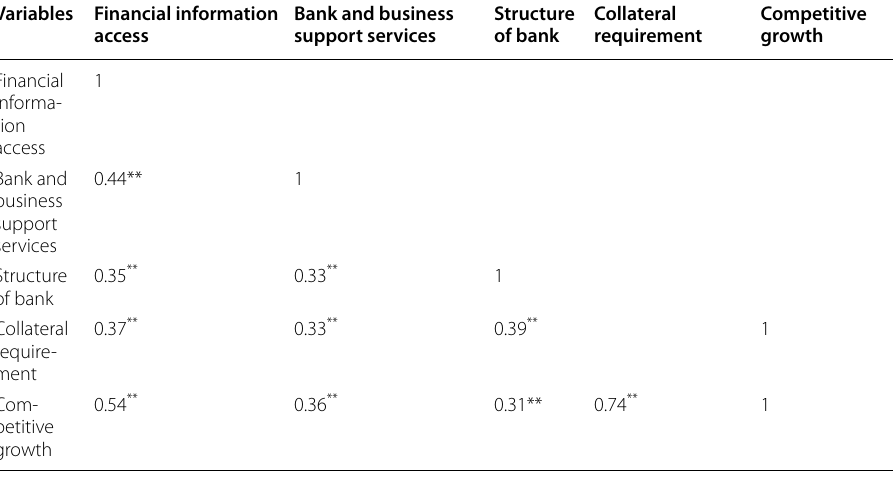
Table 2 Spearman’s correlation of factors related to access to